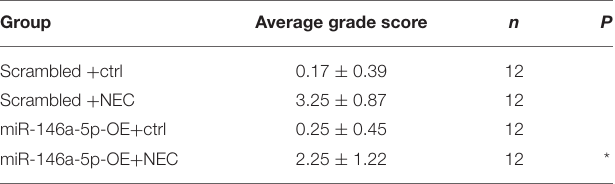
TABLE 1 | Pathological grade of mouse terminal ileum.